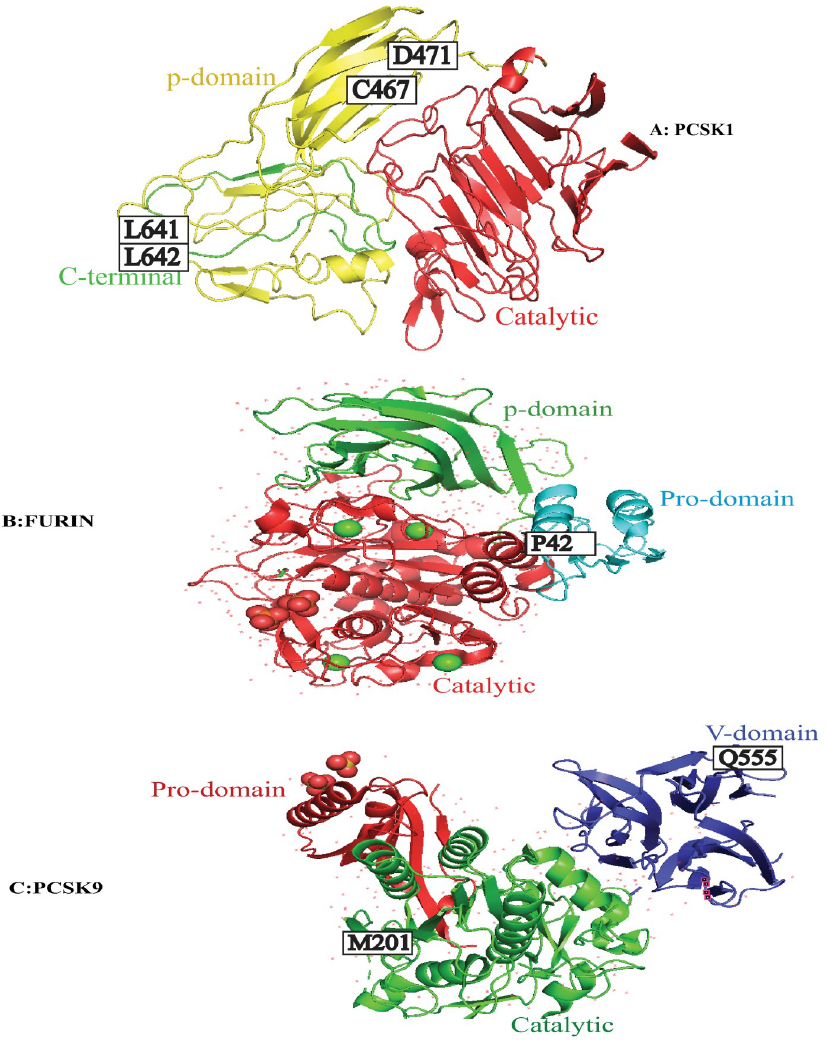
Fig 7. Sites under positive selection in the 3D structure of human PCSK9, PCSK1 and FURIN. A) Homology-based 3D model of PCSK1 catalytic (Red), p-domain (yellow) and part of C-terminal domain (green) (aa 673–731), with sites under positive selection indicated. B) 3D model of PCSK3(FURIN) catalytic (Red) and p-domain (green) (PDB: 4Z2A) and homology-based 3D model of pro-domain (blue) (aa30-108) with sites under positive selection indicated. C) 3D structure of human PCSK9 (PDB: 2PMW) catalytic, pro-domain and v-domain with sites under positive selection indicated. had isoleucine and this amino acid is converted to threonine, glutamine, arginine, glutamic acid, lysine, leucine, methionine and tryptophan in other animals (S28 File). PCSK7 is the most ancient member of this family, and its role in disease such as hyperten- sion, neurological diseases, neoplasia, breast cancer, iron hemostasis, and insulin resistance has been investigated [27, 58, 59]. PCSK7 showed positive selection in 1 site [731P], belonging to the cytoplasmic domain (Fig 1D and Table 1); this domain is important for pc7 commuting between trans-Golgi network and plasma membrane but also to enter endosomes for maximal activity [60, 61]. The proline 731 lies close to the ExEXXXL725 motif critical for endosomal sorting. This amino acid is converted to leucine in Marmota flaviventris (yellow-bellied mar- mot), Cavia porcellus (guinea pig), Heterocephalus glaber (naked mole-rat), Mus musculus